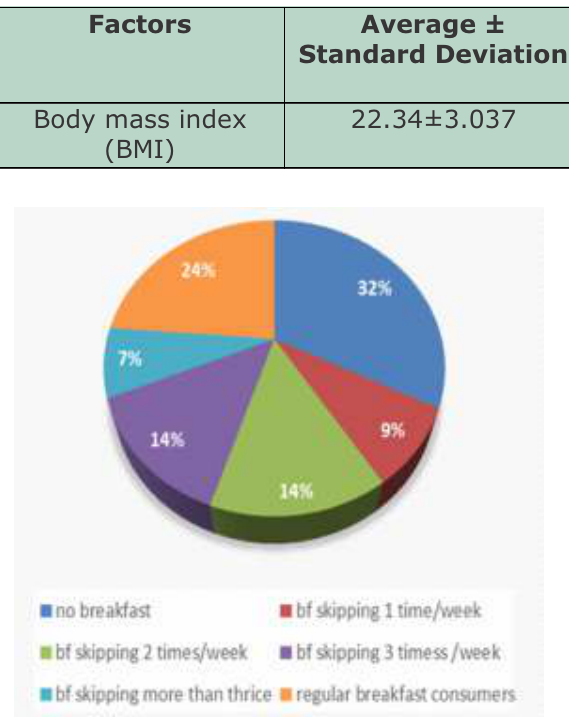
Table-II: BMI of university adolescent girls depending on the breakfast consumption pattern.